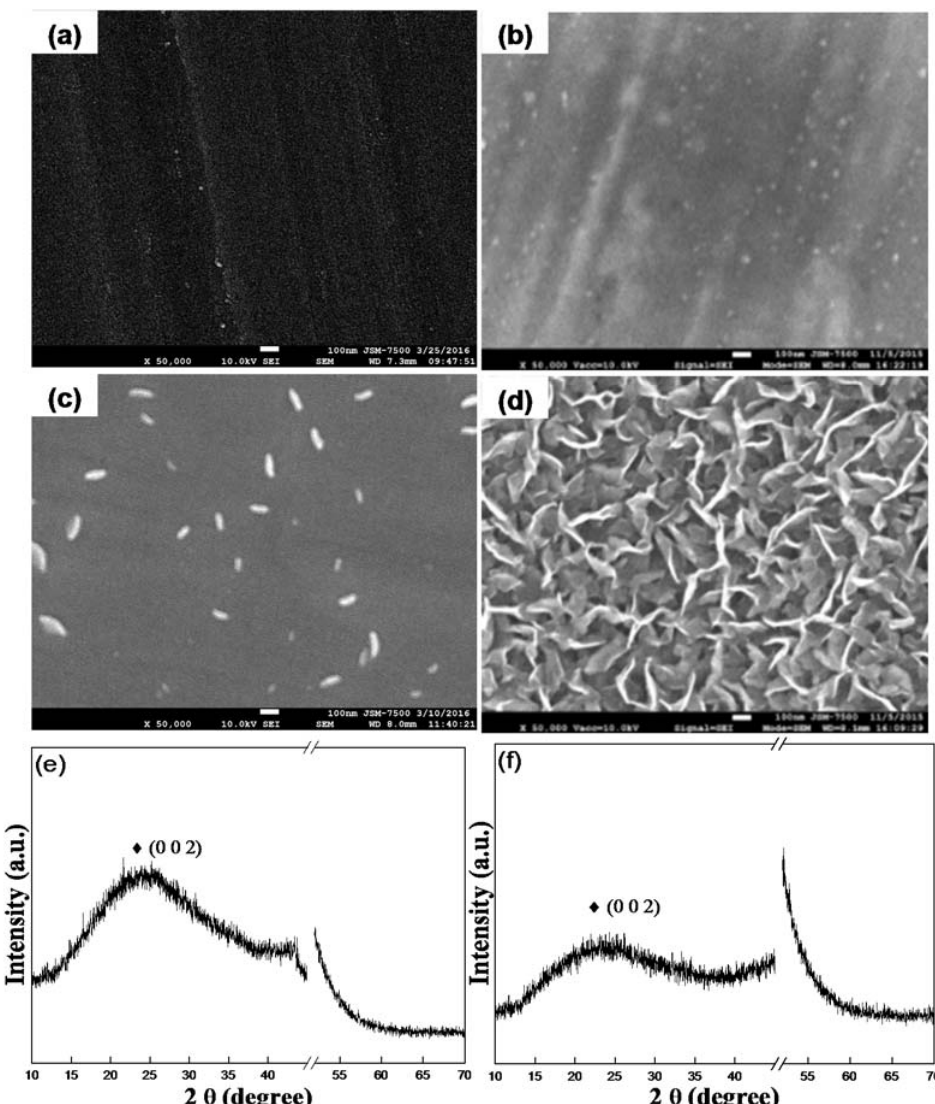
Figure 1. Scanning electron microscopy (SEM) pictures of ( a ) copper (Cu); ( b ) chemical vapor deposition (CVD) graphene (C 2 H 2 , 600 ◦ C, 5 min) on Cu; ( c ) CVD graphene (CH 4 , 350 ◦ C, 5 min) on Cu; ( d ) CVD graphene (CH 4 , 500 ◦ C, 5 min) on Cu before electrochemical corrosion experiments. X-ray diffraction (XRD) patterns of ( e ) CVD graphene (C 2 H 2 , 600 ◦ C, 5 min) on Cu; ( f ) CVD graphene (CH 4 , 350 ◦ C, 5 min) on Cu.